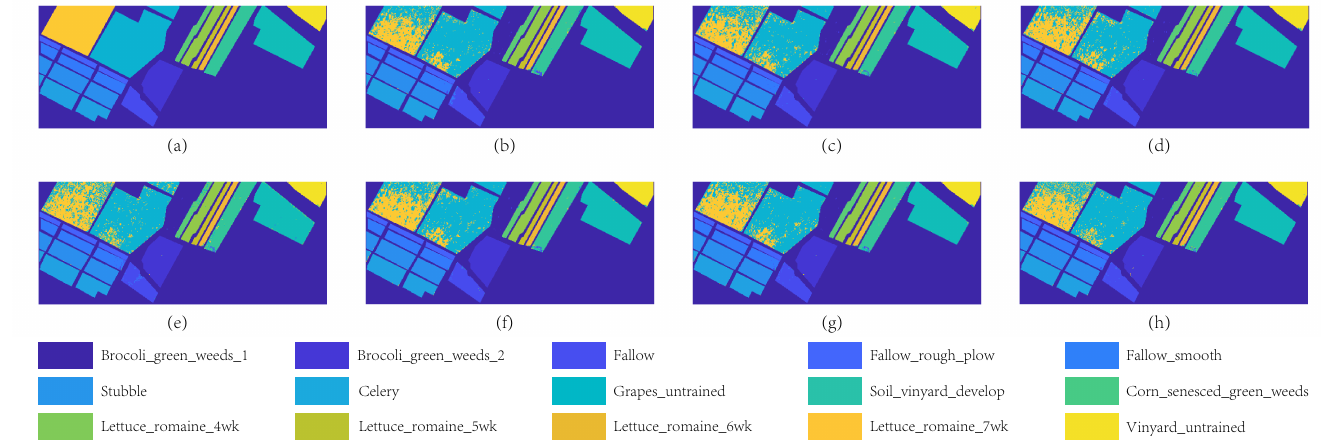
Figure 7. The visualization of classification on the Salinas dataset. ( a ) Ground truth; ( b ) PCA; ( c ) NC-OC-IE; ( d ) NC-OC-MVPCA; ( e ) PCAS; ( f ) ONR; ( g ) TRC-OC-FDPC; ( h ) BAMGC.